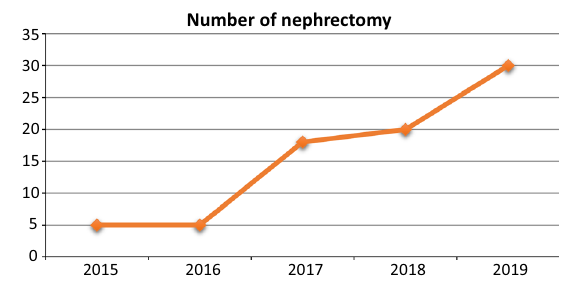
Fig. 1 Chronological evolution of laparoscopic nephrectomy in the department of urology B